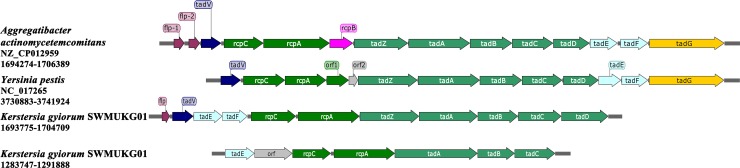
Comparison of the pilus structure in the genomes of K. gyiorum SWMUKG01, Aggregatibacter actinomycetemcomitans and Y. pestis.The box arrows represent ORFs.